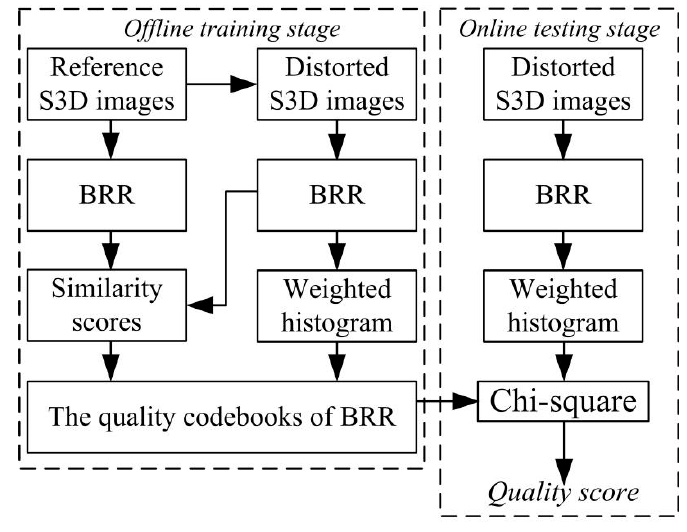
Figure 1. Block diagram for our blind S3D-IQM.